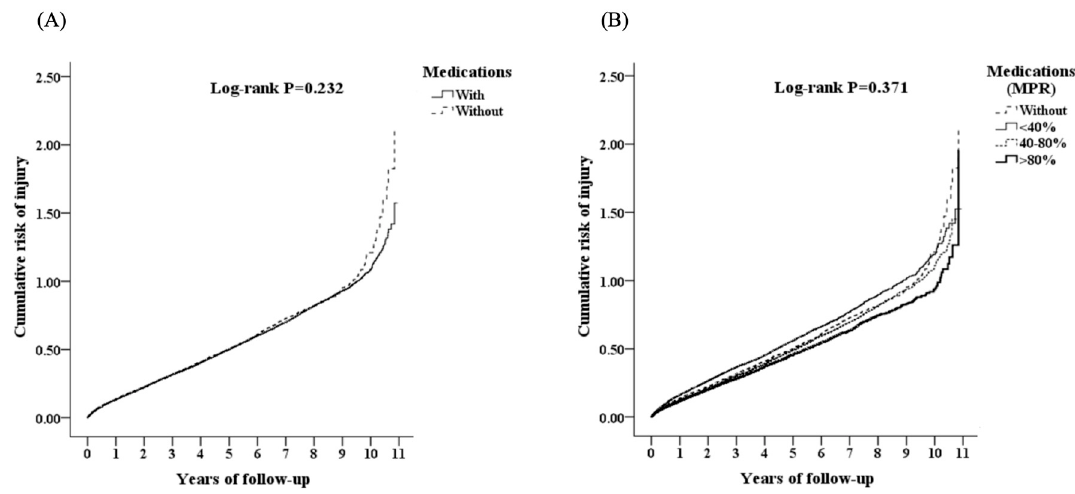
Figure 2. Kaplan–Meier analysis for ( A ) cumulative risk of injury among patients with gout and over, stratified by intervention of medications with the log-rank test and ( B ) cumulative risk of injury among patients with gout and over, stratified by adherence of medications (MPR) with the log-rank test.